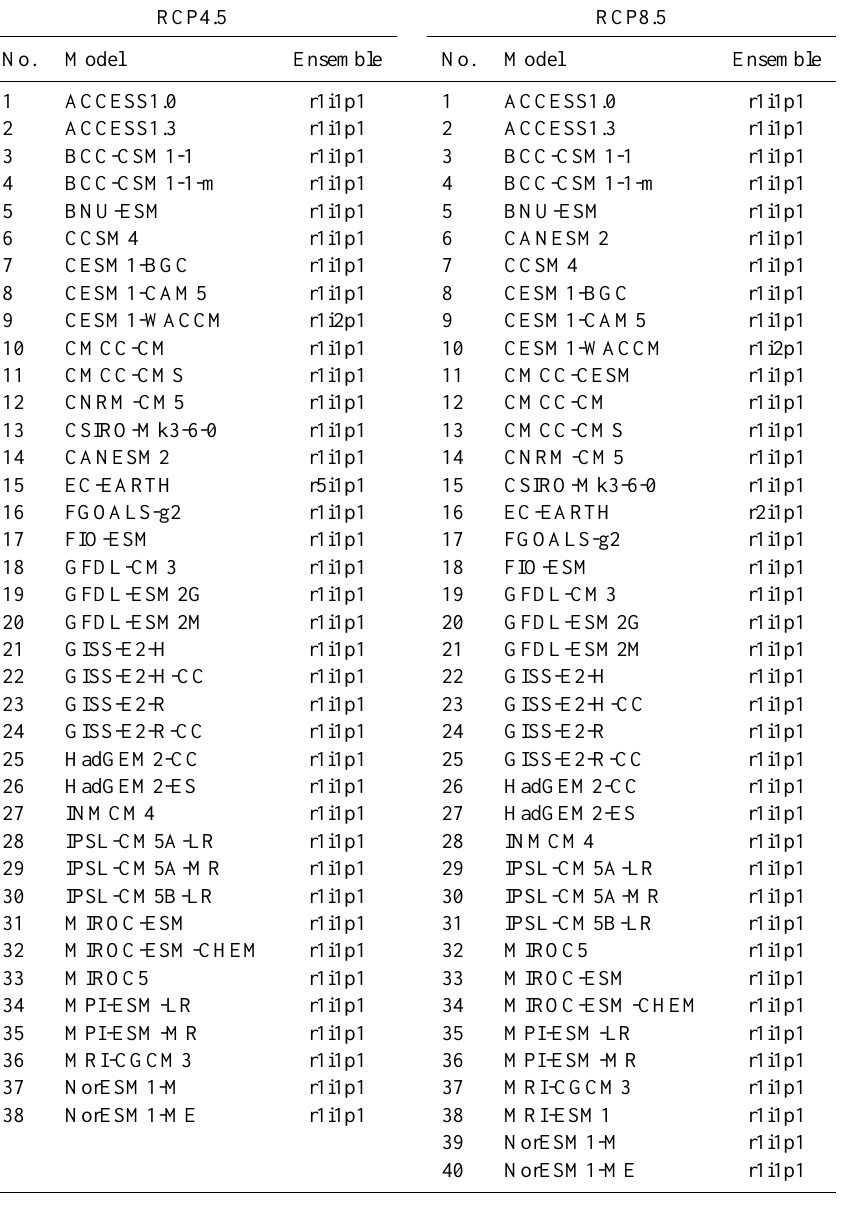
Table 1. Overview of selected GCMs used in climate impact assessment. More details of the models, modeling centers and meaning of the ensemble codes can be found at